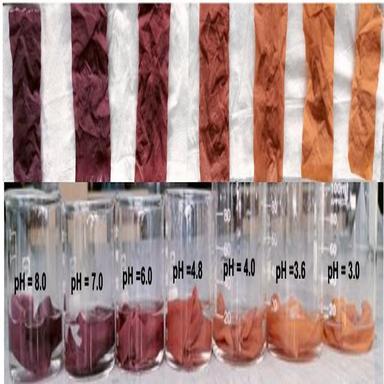
Dyed fabric in buffer solutions with different pH values.